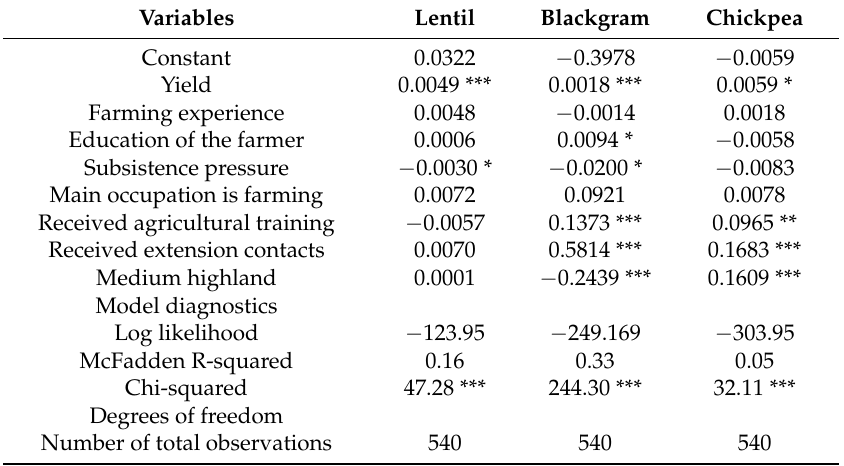
Table A2. Marginal effects of factors influencing the decision to adopt improved pulse